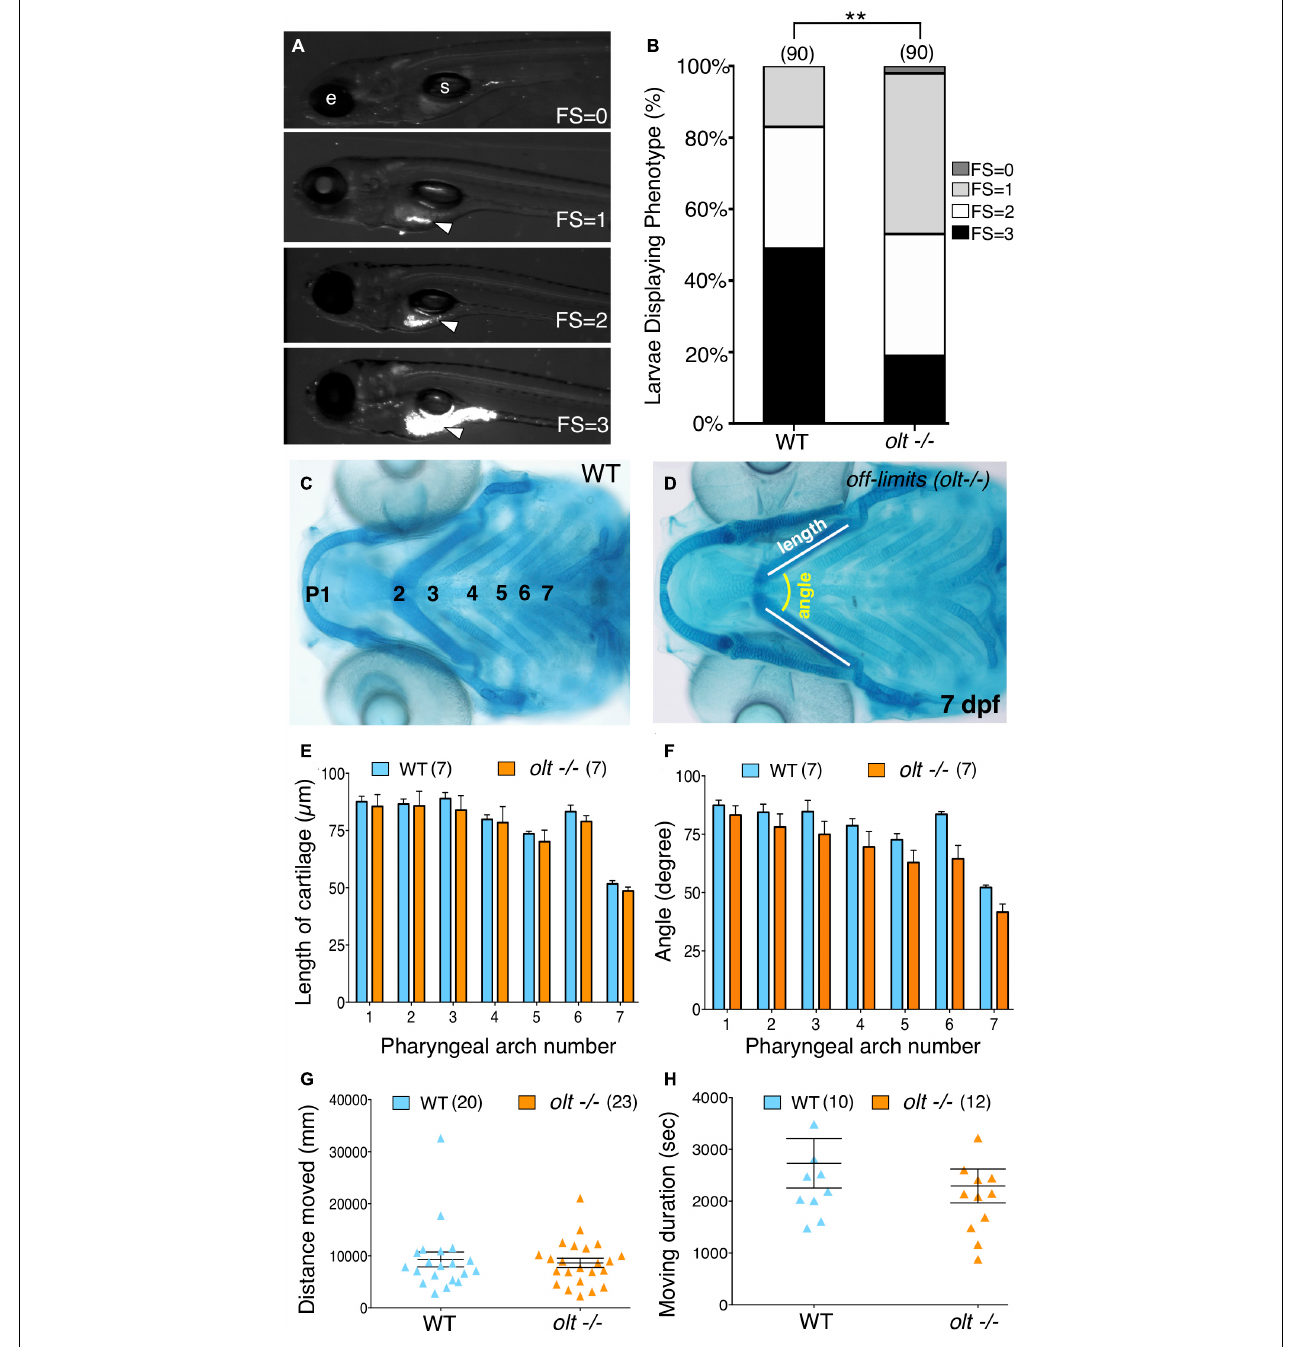
FIGURE 4 | Defective jaw movements greatly reduce food intake in olt mutants. (A) A semi-quantitative food intake assay for zebrafish larvae. Lateral views of 7 dpf larvae fed yellow–green fluorescent microspheres coated with fish food for 3 h. The fluorescent contents (arrowheads) in their guts were visualized under GFP epifluorescence, and ranged from no food with a feeding score (FS) of 0, less than 25% of the gut FS = 1, 50% of the gut (FS = 2), to a full gut (FS = 3). e, eye; s, swim bladder. (B) Distribution of feeding scores showing that a population of olt mutants ate significantly less than wildtype siblings. Pooled data from 3 experiments. Chi-square test used for testing significance (** p < 0.01). (C,D) Cartilage morphology at 7 dpf showing that the various elements develop and pattern normally in olt mutants. (E,F) Pooled data from 4 experiments. The pharyngeal arch (numbered) was measured for (E) length (white line in D ) and (F) angle (yellow arc in D ) in wildtype siblings and olt mutants. There was no difference in cartilage elements’ lengths or the angles subtended by the elements between olt mutants and wildtype siblings. (G,H) Swimming parameters in 6 dpf larvae. (G) distanced moved and (H) moving duration were analyzed and compared between olt mutant and wildtype sibling larvae with the DanioVision and EthoVision locomotion tracking software (Noldus). There was no significant difference in swimming distance or duration between olt mutants and wildtype siblings. Pooled data from 2 experiments. Number of larvae in parenthesis. The two-tailed student t -test was performed to test for significance (E–H)